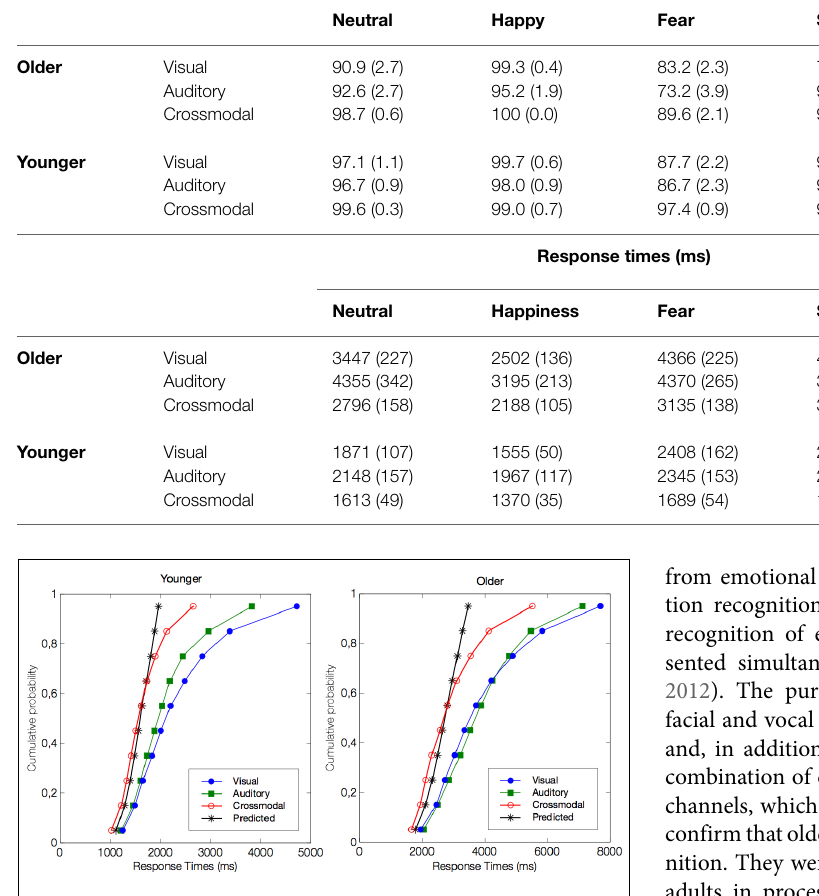
FIGURE 3 | Test for the violation of race model inequality. The figure illustrates the cumulative probability curves of the RT under the visual (blue circles), auditory (green squares), and crossmodal conditions (red circles). The summed probability for the visual and auditory responses is depicted by the race model curve (marked by an asterisk). Note that the crossmodal responses are faster than the race model prediction for the four